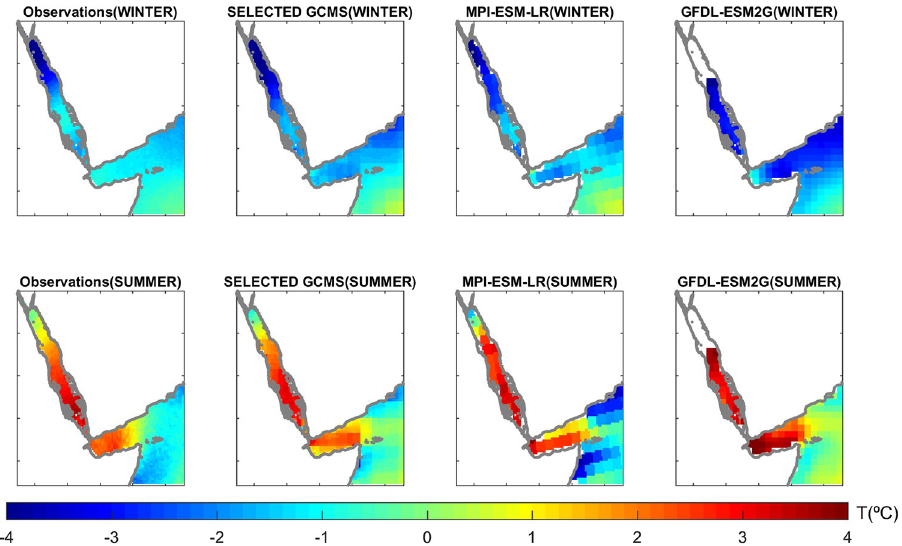
Fig 4. Sea surface temperature anomalies with respect to the annual average (in ˚C) in winter (Top) and summer (Bottom), for the observations (first column), average of the selected GCMs (see “Model Selection” section; second column), an example of GCM with good skills (MPI-ESM-LR; third column) and an example GCM with low skills (GFDL-ESM2G; last